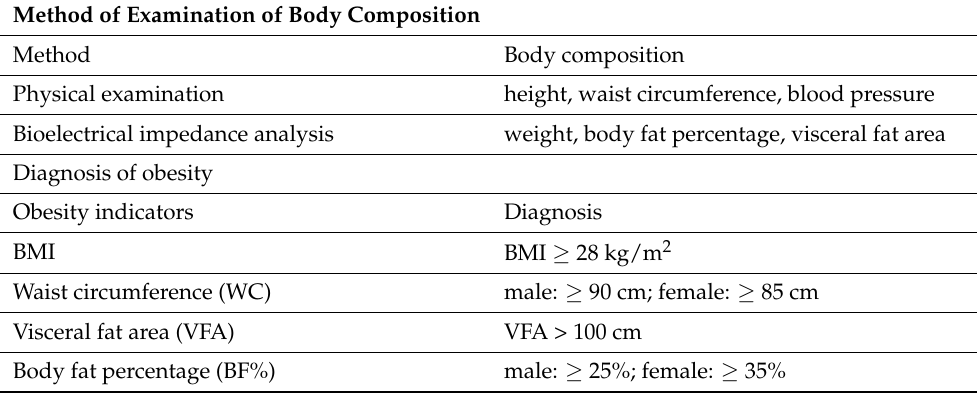
Table 1. Measurement of body composition and diagnosis of